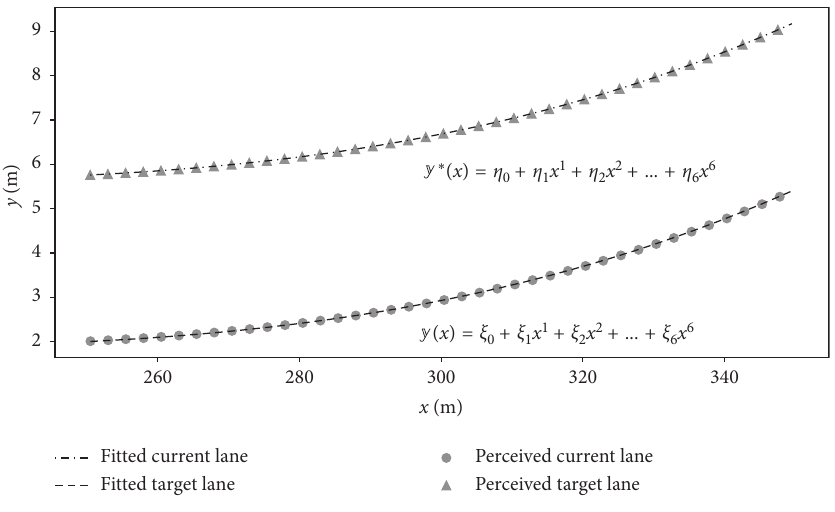
Figure 6: Road curve fitting using the polynomial regression